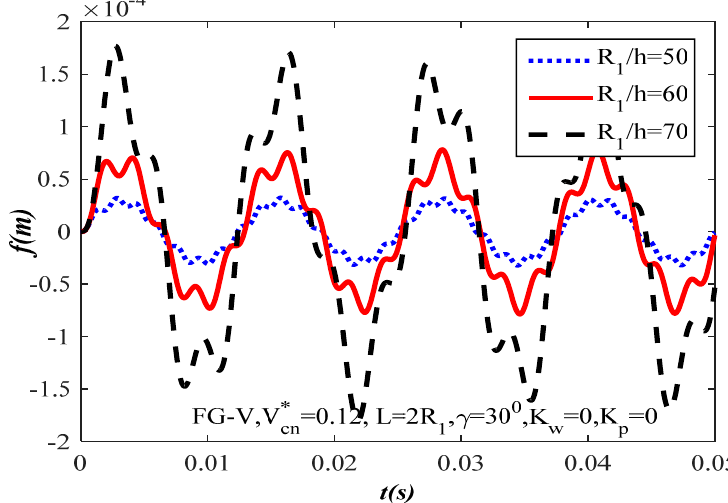
/ R h on the dynamic response of the FG-CNTRC truncated conical shells. Figure 7. Effect of ratio Figure 7. Effect of ratio R 1 / h on the dynamic response of the FG-CNTRC truncated conical 1